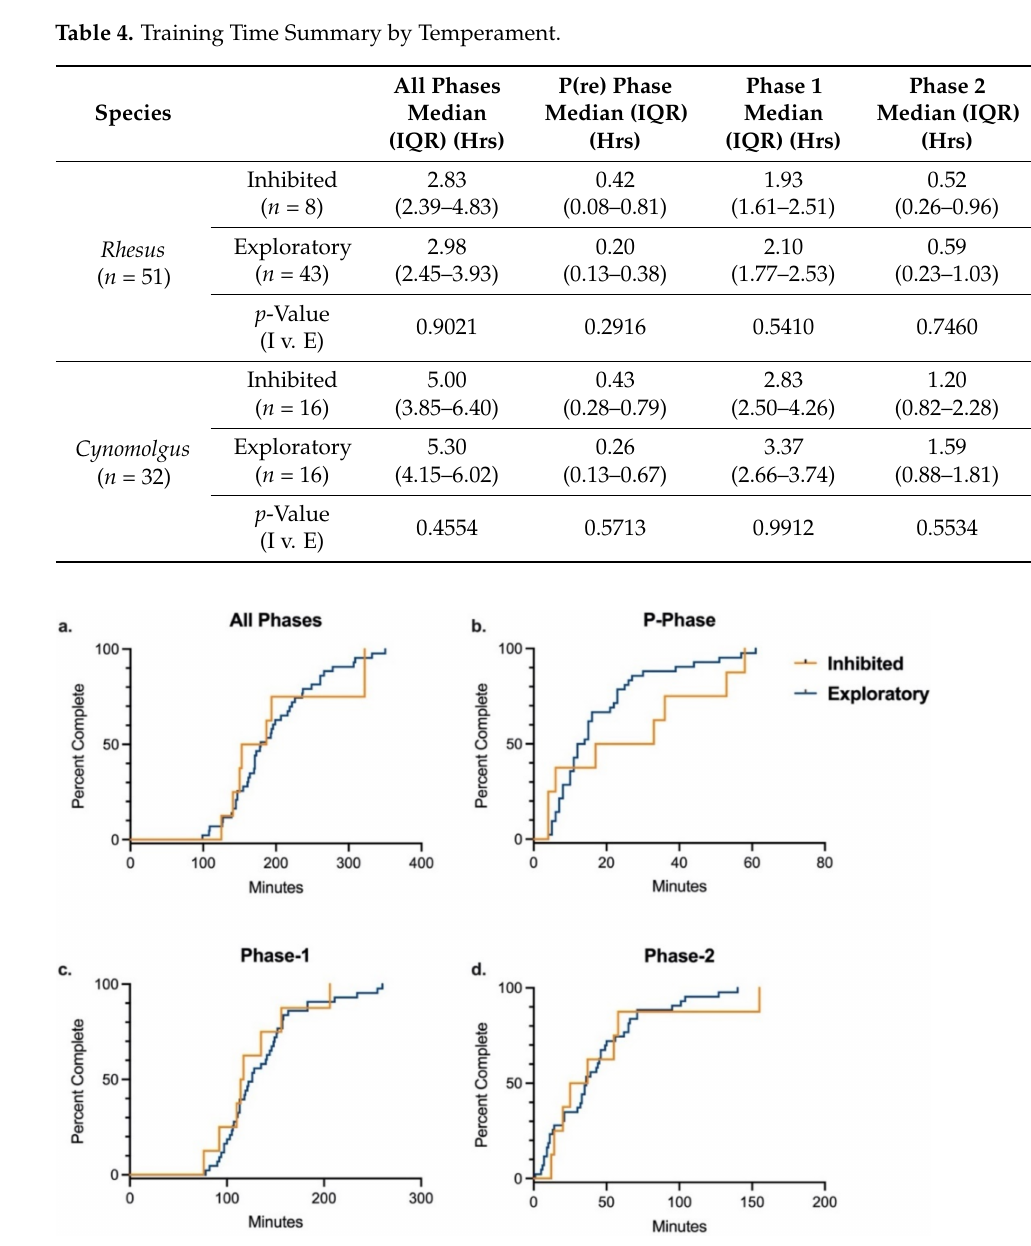
Figure 2. Training Completion Time by Temperament in Rhesus Macaques. Kaplan–Meier time- to-event analysis comparing the time required to successfully complete all phases and individual phases of the training paradigm between inhibited and exploratory rhesus macaques. There were no significant differences between groups for completing ( a ) all phases (Log-rank χ 2 = 0.03 (df = 1), p = 0.86), ( b ) P-Phase (Log-rank χ 2 = 1.15 (df = 1), p = 0.30), ( c ) Phase-1 (Log-rank χ 2 = 0.50 (df = 1), p = 0.50), or ( d ) Phase-2 (Log-rank χ 2 = 0.26 (df = 1), p =